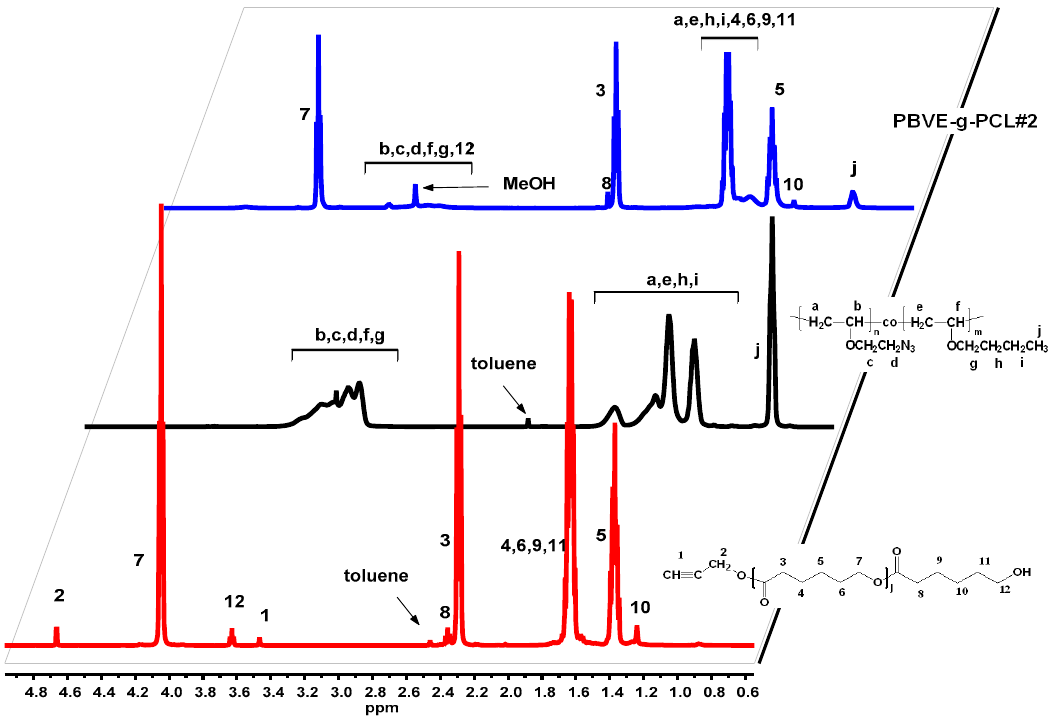
Figure 7. Monitoring the synthesis of sample PBVE– g –PCL#2 via the grafting “onto” methodology by 1 H NMR spectroscopy in CDCl 3 .